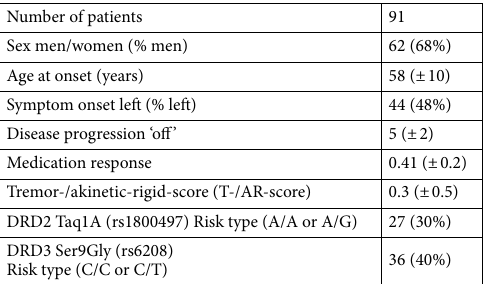
Table 1. Patient demographics. Variables included in cluster analysis. Mean (SD) in continuous variables; absolute numbers and percentage in dichotomous